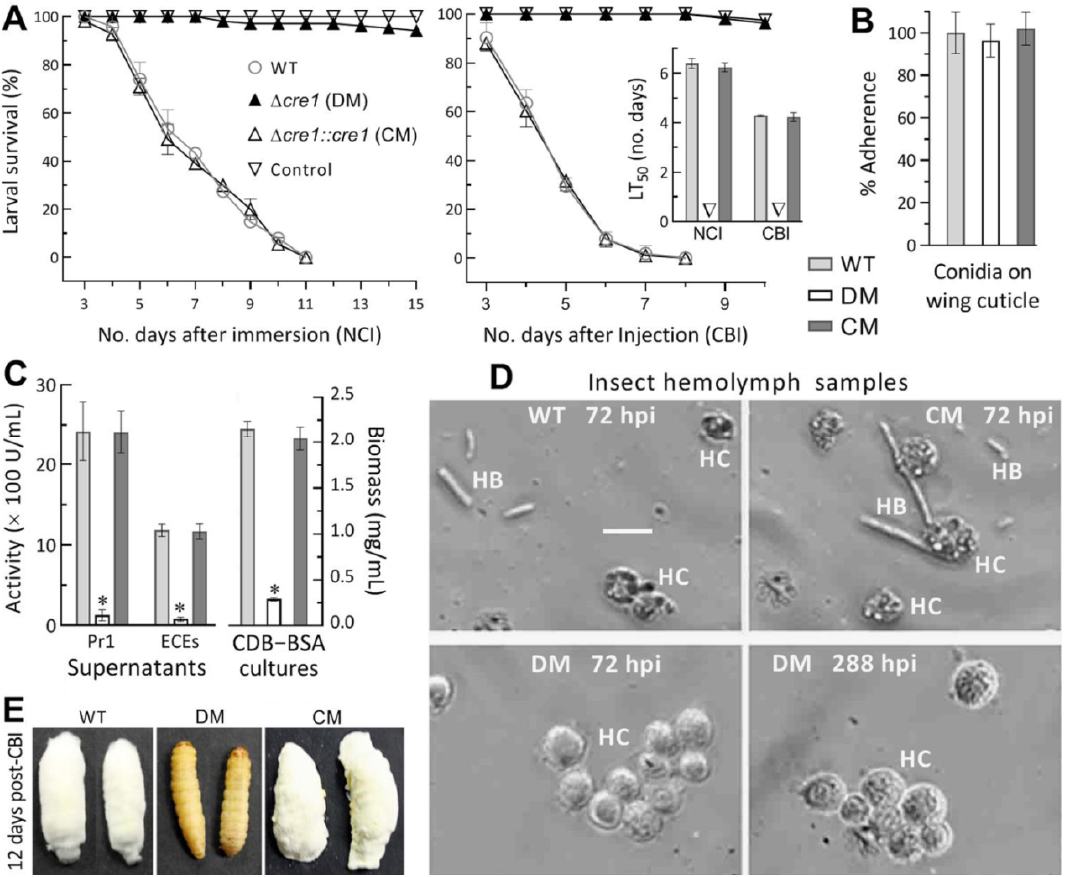
Figure 2. Role of cre1 in normal infection and related cellular events of B. bassiana . ( A ) Time-survival trends of G. mellonella larvae after topical application (immersion) of a 10 7 conidia/mL suspension for normal cuticle infection (NCI) and intrahemocoel injection of ~500 conidia per larva for cuticle-bypassing infection (CBI) and LT 50 s (no. days) estimated from the trends. ( B ) Conidial adherence to locust hind wing cuticle assessed as percent ratios of pre-wash counts over post-wash counts with respect to the WT standard. ( C ) Total activities of cuticle-degrading ECEs and Pr1 proteases quantified from the supernatants of 3-day-old CDB-BSA cultures and biomass levels measured from the same cultures initiated by shaking 10 6 conidia/mL suspensions at 25 °C. ( D ) Microscopic images (scale: 20 μm) for the presence and abundance of hyphal bodies (HB) and host hemocytes (HC) in hemolymph samples taken from surviving larvae 72 and 288 h post-injection (hpi). Note that the Δ cre1 mutant (DM) produced no hyphal body at all even at 288 hpi, accompanied by consistent aggregation of host hemocytes. ( E ) Images of hyphal outgrowths formed by control strains (WT and CM) on the surfaces of insect cadavers and of living status of larvae 12 days pest-CBI with DM. * p < 0.001 ( C ). Error bars: SDs of the means from three independent replicates.